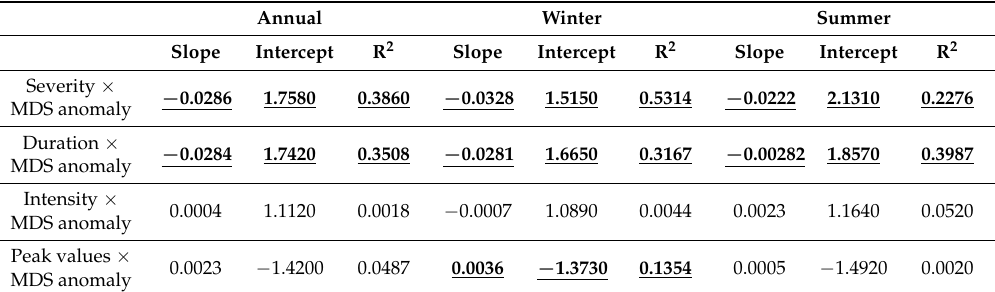
Table 1. The significance (a significance level of 95%), slope, intercept and coefficient of determination (R 2 ) for severity, duration, intensity and peak values with respect to MDS anomaly on annual, winter and summer scales. Underlined bold numbers represent a significant linear relationship with MDS